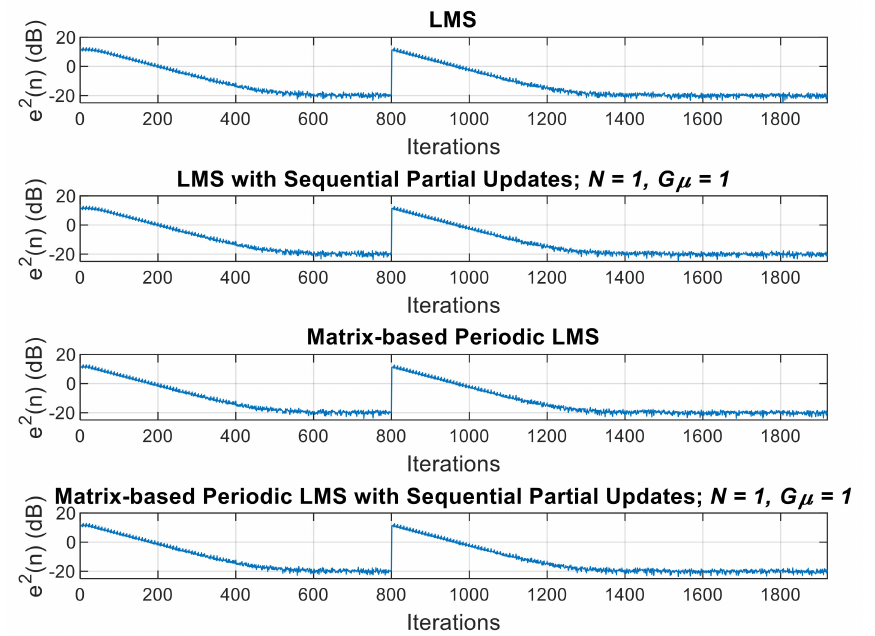
Figure 12. Learning curves comparison. Version 2 of the experiment: desired signal d 2 ( n ) and reference signal x 2 ( n ) . ( a ) LMS, ( b ) LMS with Seq PU; N = 1 and G µ = 1, ( c ) P-LMS, ( d ) P-LMS with Seq. PU; N = 1 and G µ = 1. Average of 50 runs. The performance measure used is the instantaneous squared error in logarithmic scale (dB).